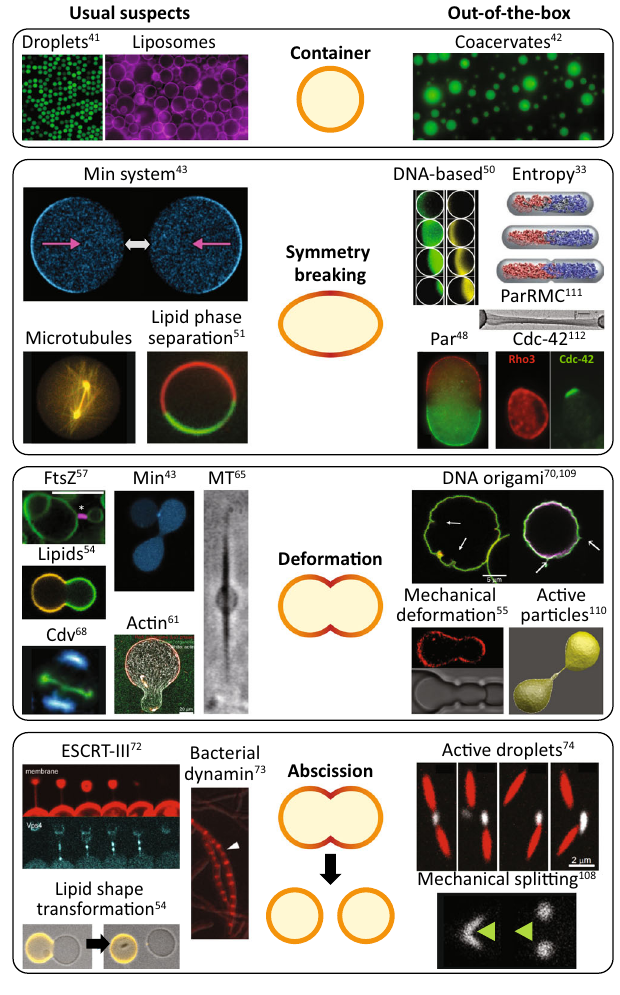
Fig. 4 Synthetic cell division. Alternative synthetic cell container and the stages of symmetry breaking, deformation, and abscission during cell division. For each step, well-characterised (left) and alternative “ out-of-the- box ” candidates (right) are presented. Images depicting droplets, coacervates, lipids and lipid shape transformation, mechanical deformation, FtsZ, and DNA origami are reproduced from refs. 41,42,54,55,57,70 , respectively, under the CC BY 4.0 licence. Images depicting Min system, Min are reproduced/adapted from ref. 43 under the CC BY-NC 4.0